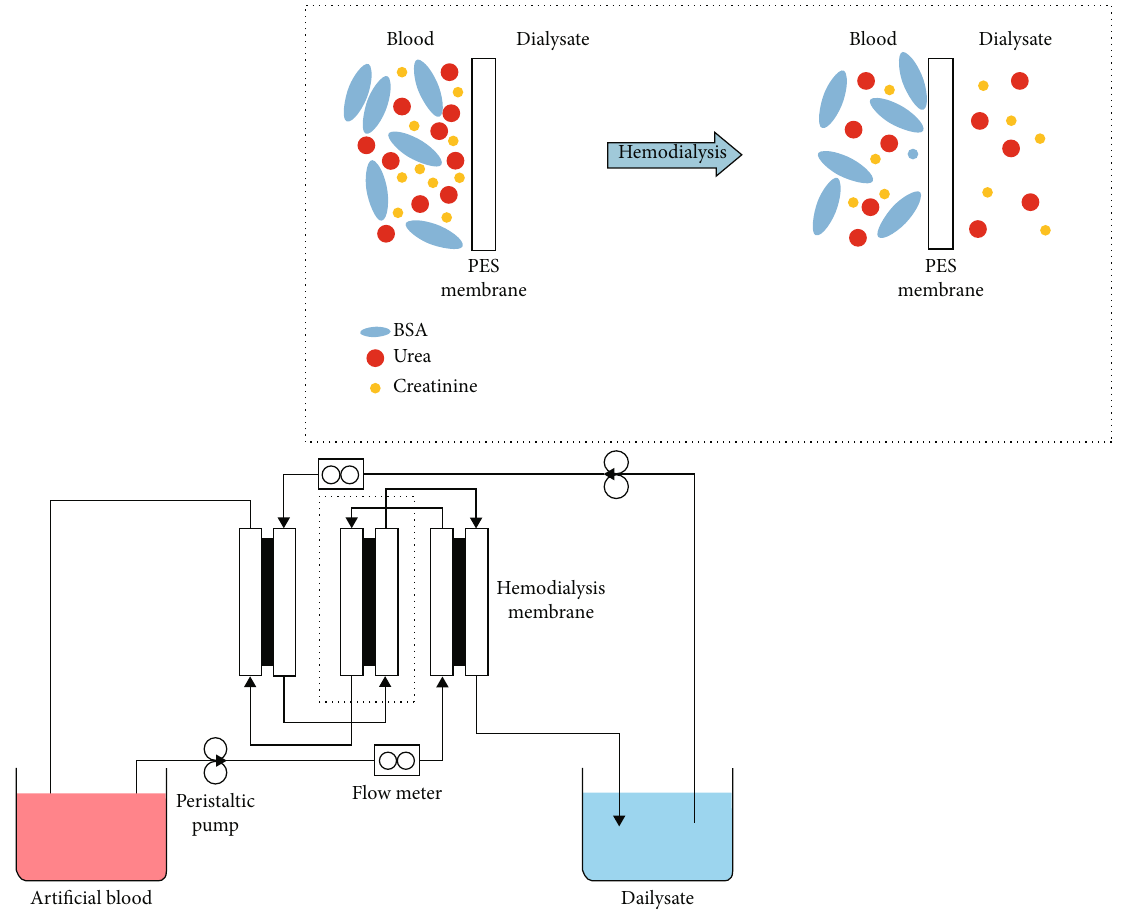
Figure 1: Schematic diagram of multimembrane dialysis system. Table 2: Composition of arti fi cial blood and